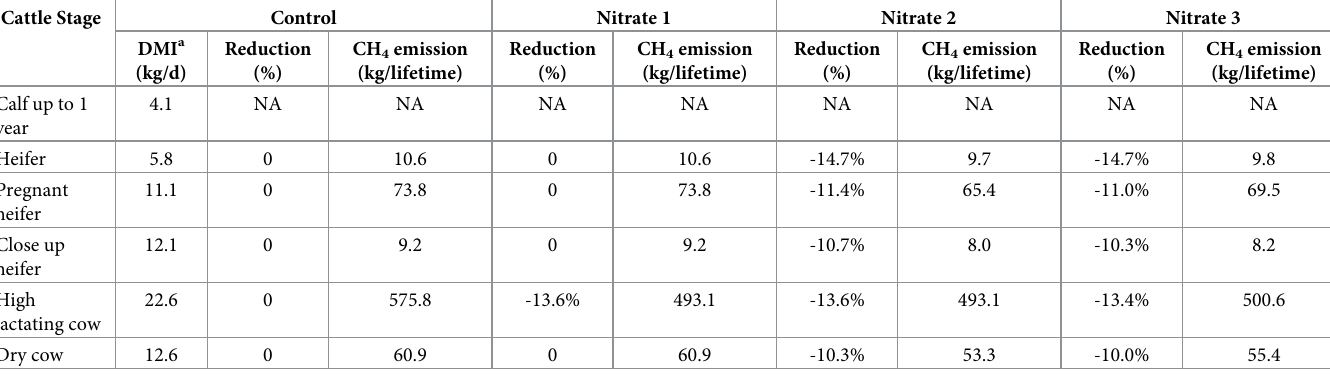
Table 2. Enteric methane reduction rates and total emissions per life cycle at different dairy growing stages for control and nitrate treatment scenarios. Cattle Stage Control